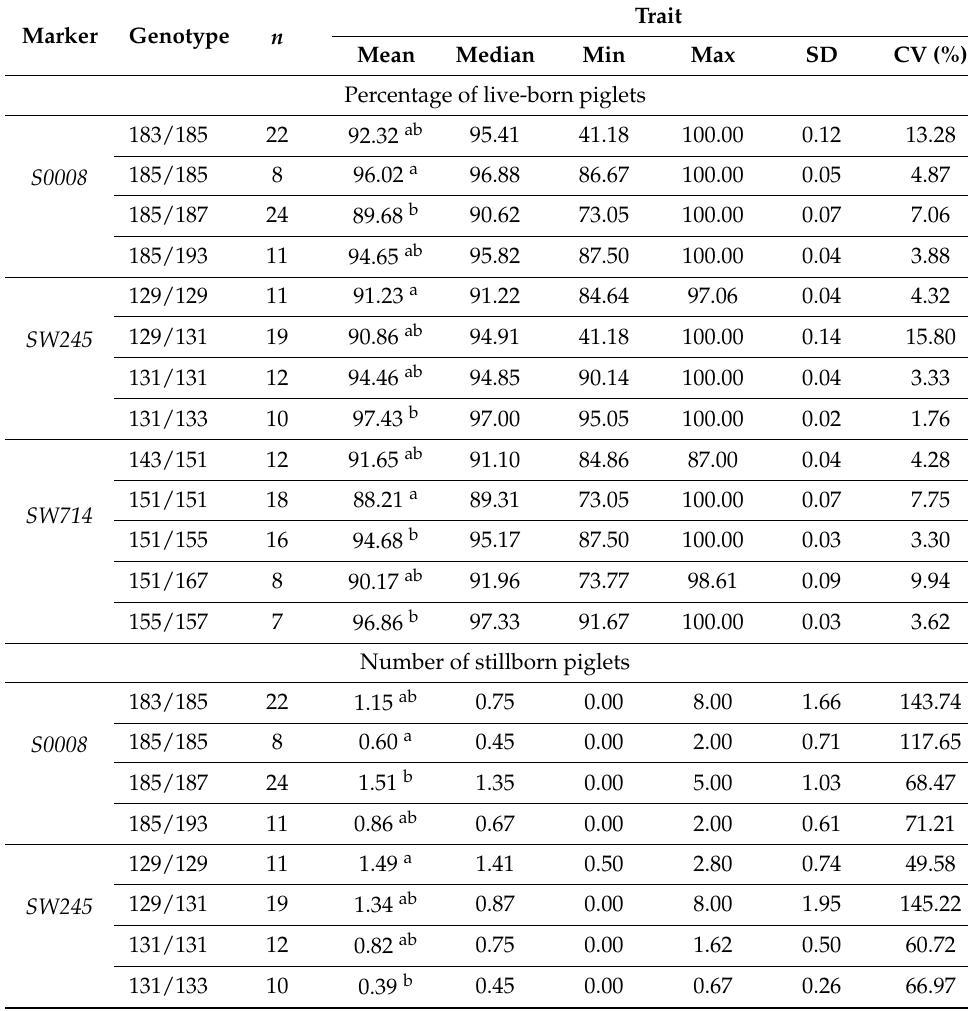
Table 4. Reproductive performance indicators in sows, across both breeds studied, depending on their genotype and the analyzed microsatellite